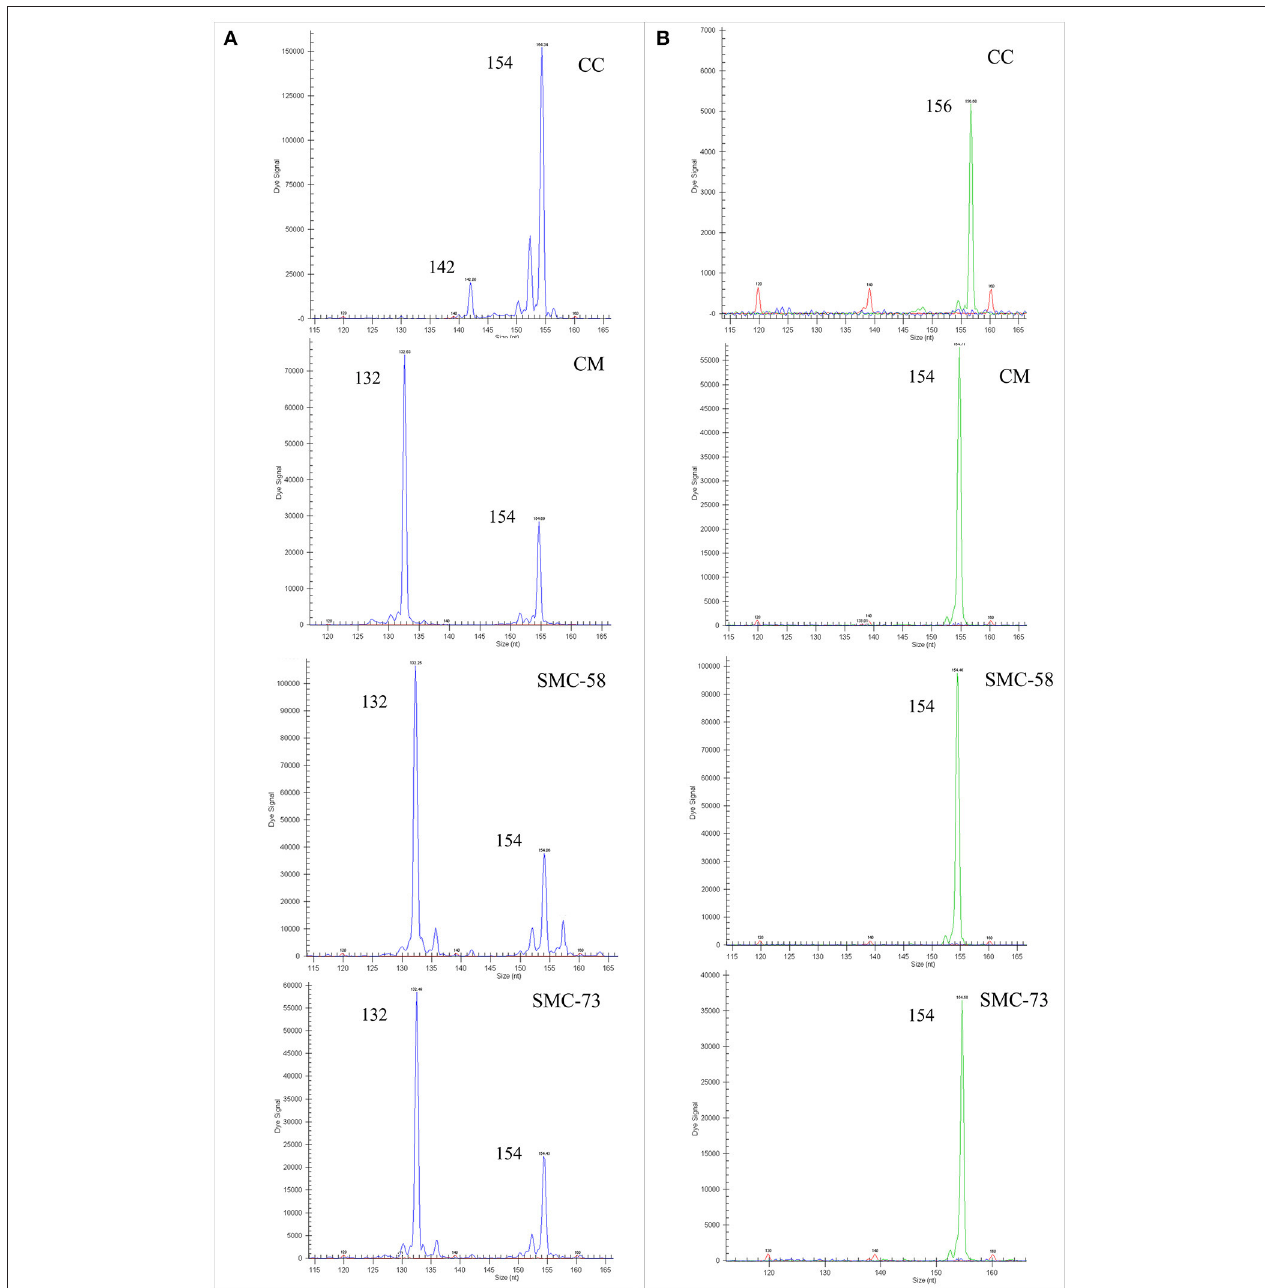
FIGURE 2 | Electropherograms of the somatic hybrids SMC-58 and SMC-73 and their parents C. macrophylla (CM) and Carrizo citrange (CC) displaying allelic losses. (A) JK-TAA41 SSR marker on LG 2. (B) Ci08A10 SSR marker on LG 3. Numbers indicate the size of the amplified allele in nucleotides (nt).